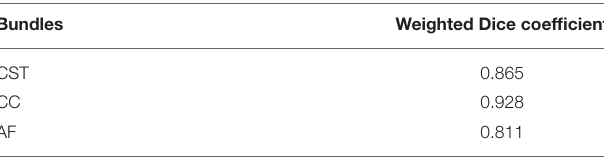
TABLE 1 | Comparison between offline and online algorithms using the Dice coefficient.